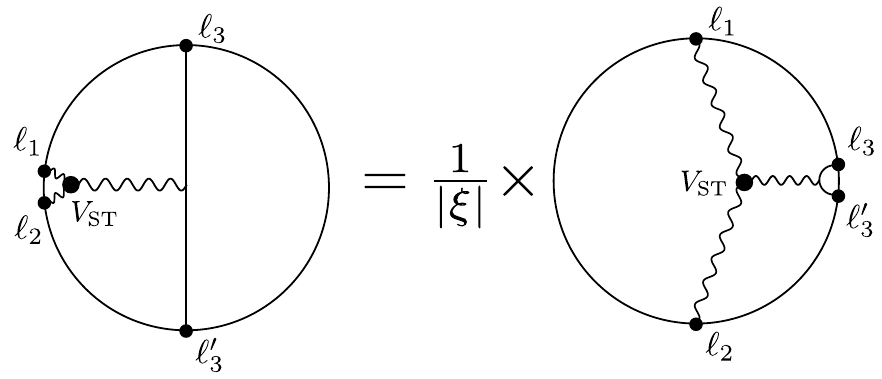
Figure 10 . A conformal transformation on the boundary that clarifies the behavior of the D E correlator in the ‘ j (0) j (0) O 3 1 2